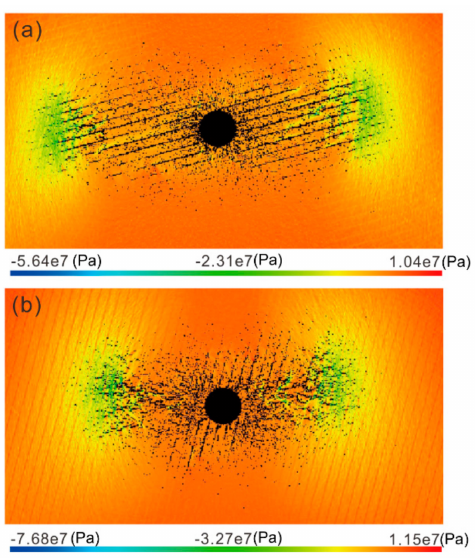
Figure 6. Distribution of the minor principal stress field after hydraulic fracturing for bedding orientations of 15 ◦ and 75 ◦ . The boundary stress and injection rate were the same as for the base model.